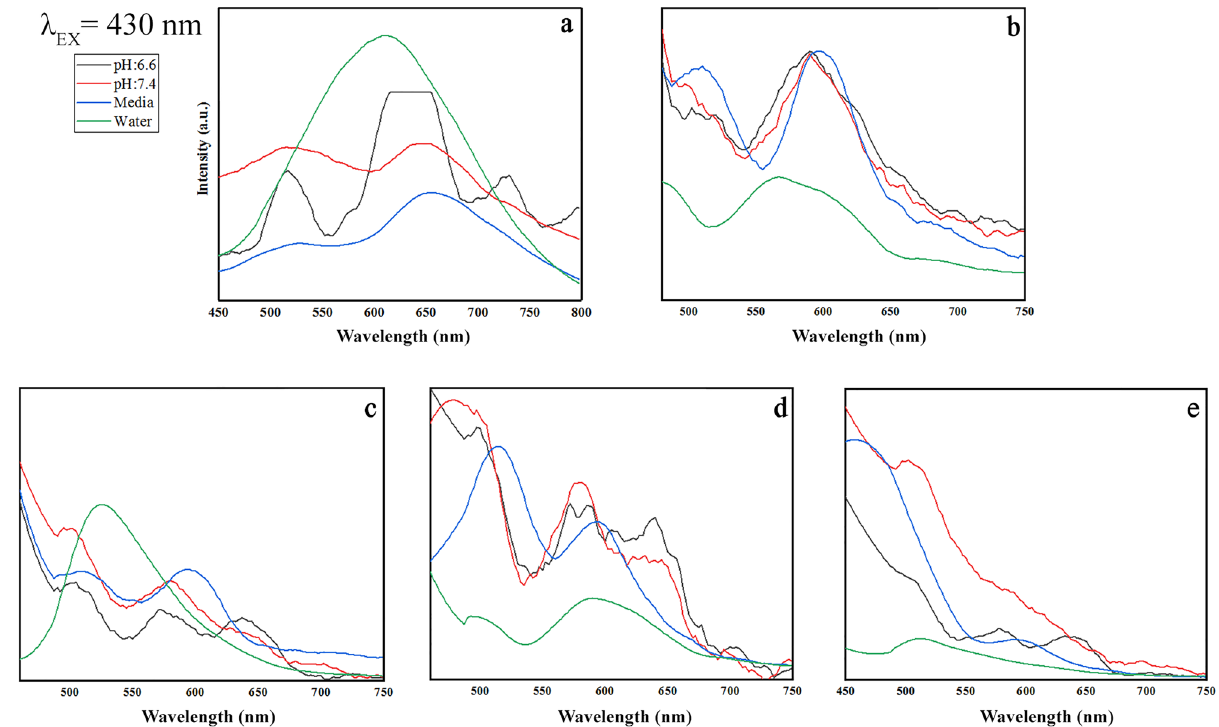
Figure 3. Emission patterns of ( a ) GO, ( b ) GO-PEG, c ) GO-PEG-Fe 3 O 4 , ( d ) GO-PEG-Au, and ( e ) GO-PEG-FA at the excitation wavelength of 430 nm in water, cell media (DMEM), and PBS at two different pH values (pH 6.6 and 7.4).